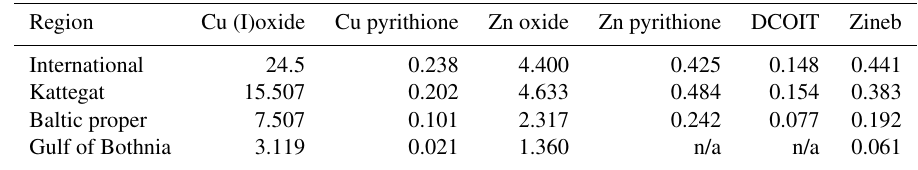
Table 3. Antifouling paint leaching rates by sea area. All values given in µgcm − 2 d − 1 . Note that ZnO and Cu(I)oxide are reported as mass of Zn and Cu, which is in contrast to CuPyr, DCOIT and zineb where the total mass or organometallic molecule is considered. Region Cu (I)oxide Cu pyrithione Zn oxide Zn pyrithione DCOIT